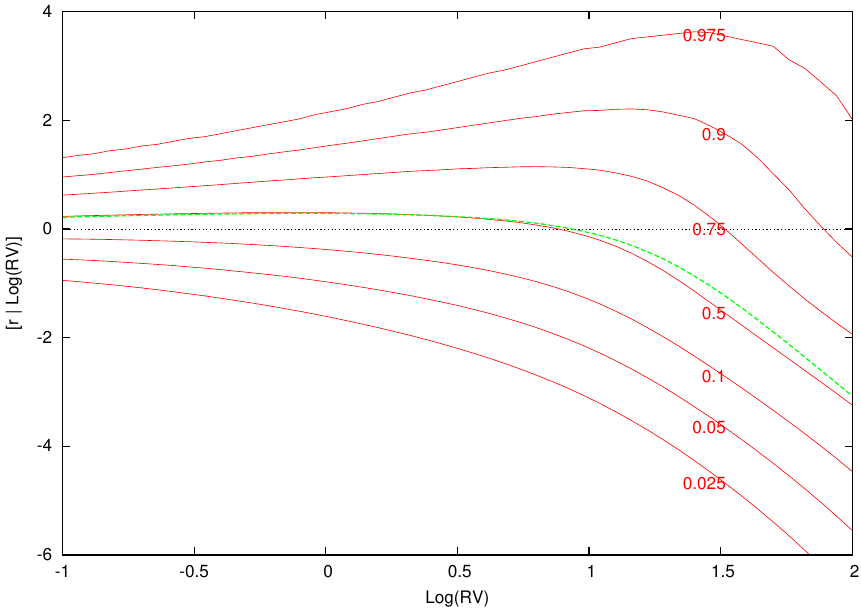
Figure 13. Quantiles of excess returns given log ( RV t ) for high volatility. This figure displays the quantiles of the distribution of excess returns conditional on log ( RV ) for I t − 1 , t = 2008 : 12. The green dotted line is the expected excess return given log ( RV ) .